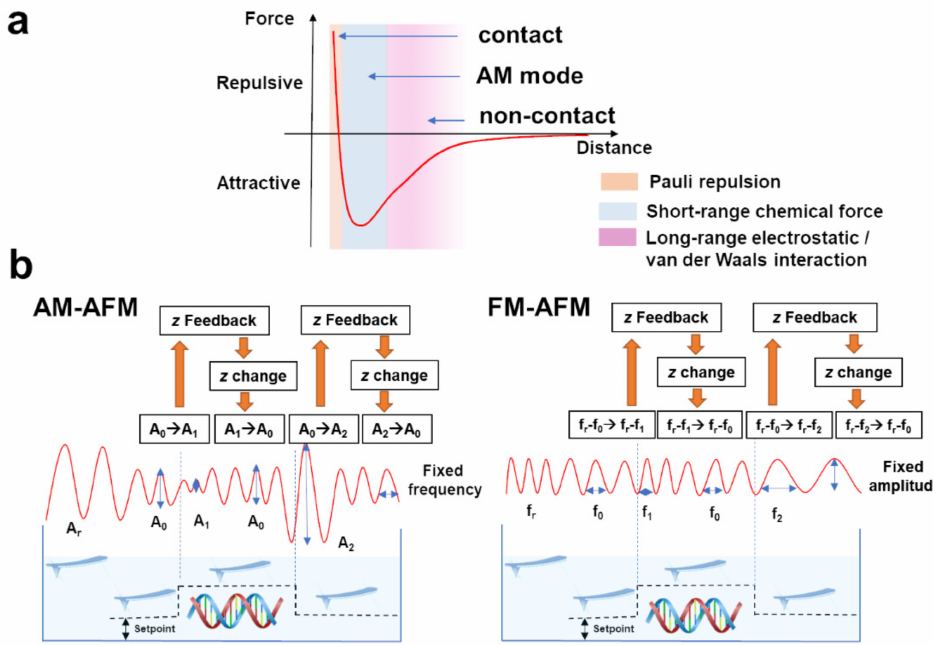
Figure 1. ( a ) Force regimes for contact, AM-AFM and FM-AFM. ( b ) Schematic representation of the working principles of AM-AFM (left panel) and FM-AFM (right panel)